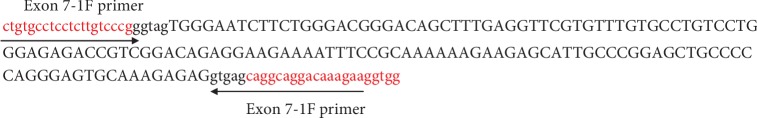
Nucleotide sequence of the amplified PCR product (188 bp) representing exon 7 of rat p53 gene in the HCC-induced group.